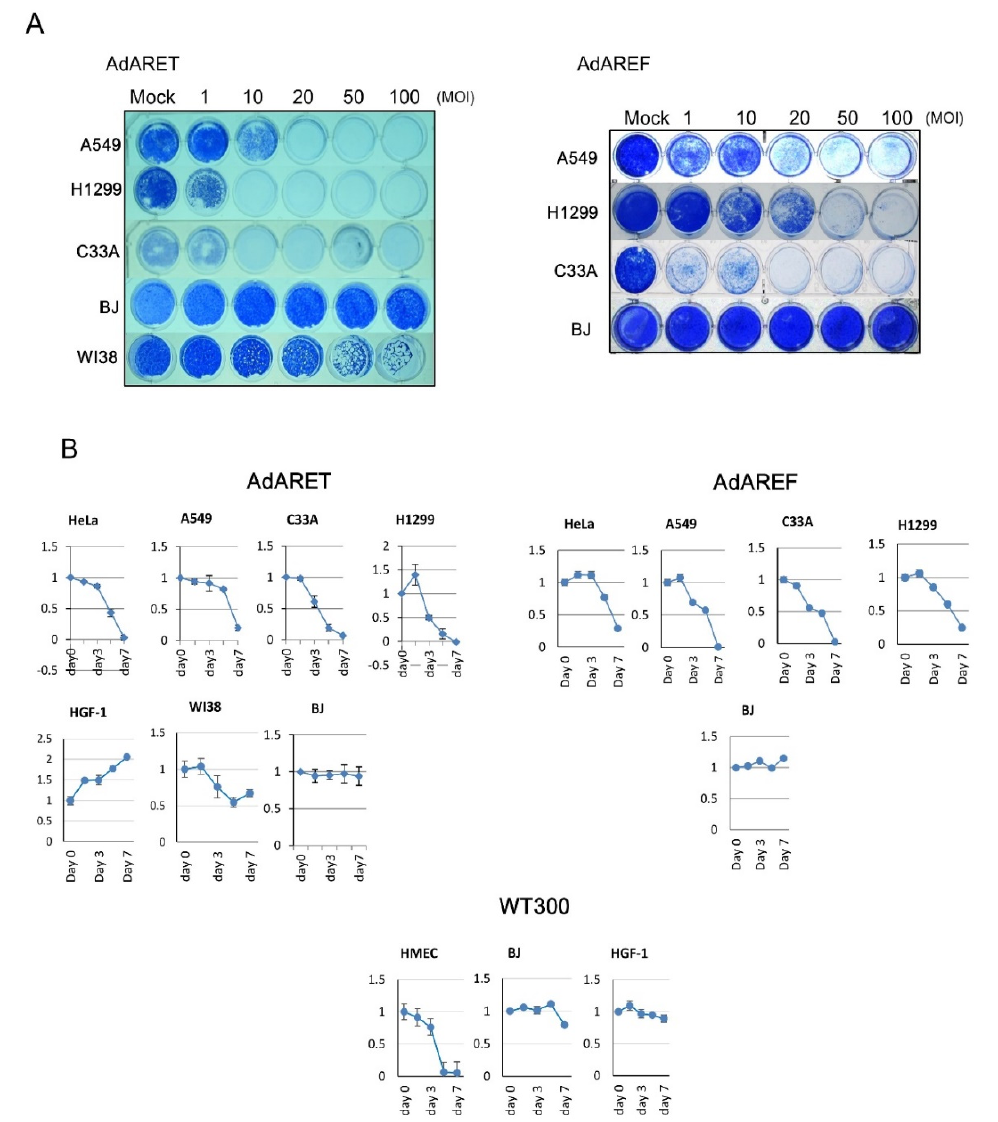
Figure 3. In vitro cell lysis activity of AdARET and AdAREF. ( A ) Cancer (A549, H1299, and C33A) and normal (BJ and WI38) cells were infected with AdARET and AdAREF at the MOIs indicated. Cells were stained with Coomassie brilliant blue seven days after infection. Living cells were stained blue. ( B ) The cell viability of AdARET, AdAREF, and WT300-infected cells was measured using the XTT assay. The indicated cancer and normal cells were infected with the virus at an MOI of 100 vp/cell and cell viabilities were estimated 0, 1, 3, 5, and 7 days after infection.